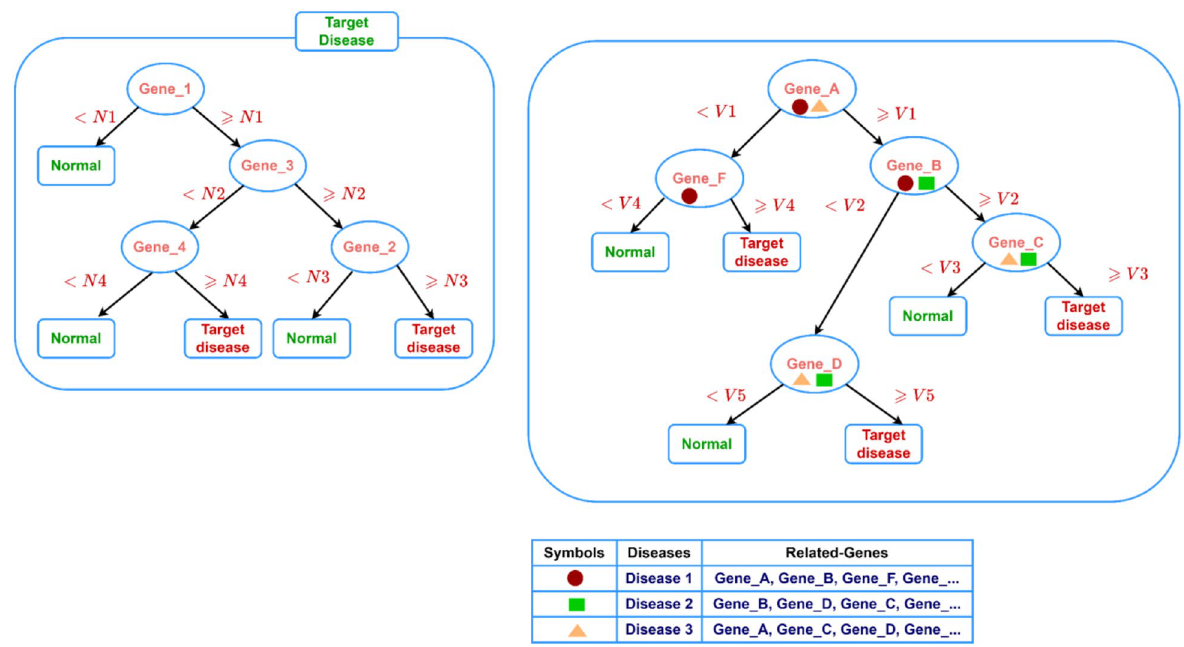
Figure 2. Decision Tree model. The left panel illustrates the traditional approach that detects gene-disease associations, while the right panel illustrates the disease-disease association as the output of